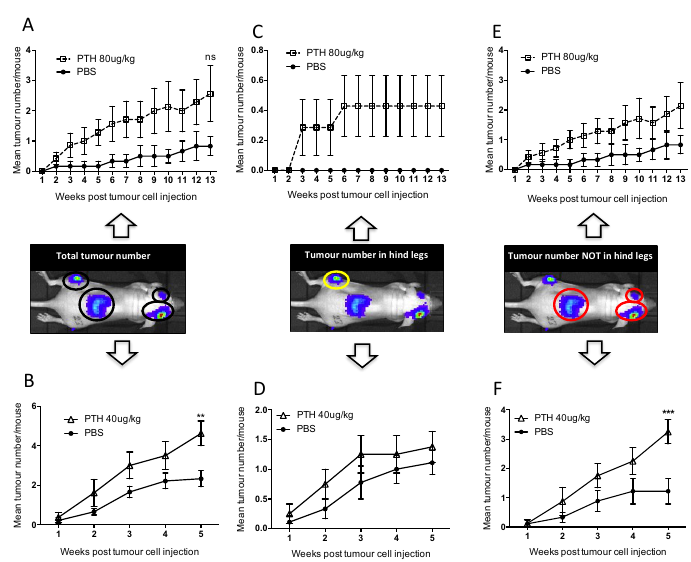
Figure A1. Tumour distribution at different skeletal sites. Twelve-week-old female BALB/c nude mice were treated with 80 μg/kg PTH or PBS ( A , C , E ) and 40 μg/kg PTH or PBS ( B , D , F ) before injection of DiD-labeled MDA-MB-231-tomato-luc2 cells and monitoring of tumour growth by in vivo bioluminescence imaging. The number of detectable luciferase positive tumours was recorded for each mouse and is shown in three categories including ( A,B ) the total number of tumours, ( C , D ) tumours detected in hind legs and ( E , F ) tumours detected in all other sites except the hind legs. Data is presented as mean tumour number/mouse ± SEM and statistical analysis was performed using matched two-way ANOVA and multiple comparison post-test. * is 40 μg/kg PTH vs. PBS and ** is p < 0.01 and *** is p < 0.001.